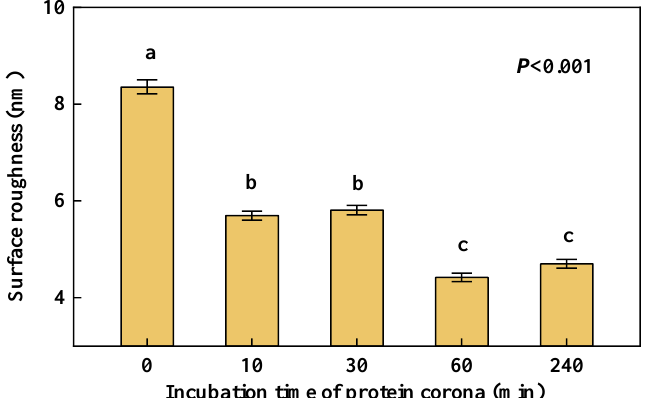
Figure 5. Surface roughness changes of PS NPs and the PC over time. Dates are means ± SE ( n = 30). Different letters indicate a significant difference at p < 0.05. Table 1. Polydispersity index (PDI) of PS NPs and the PC.